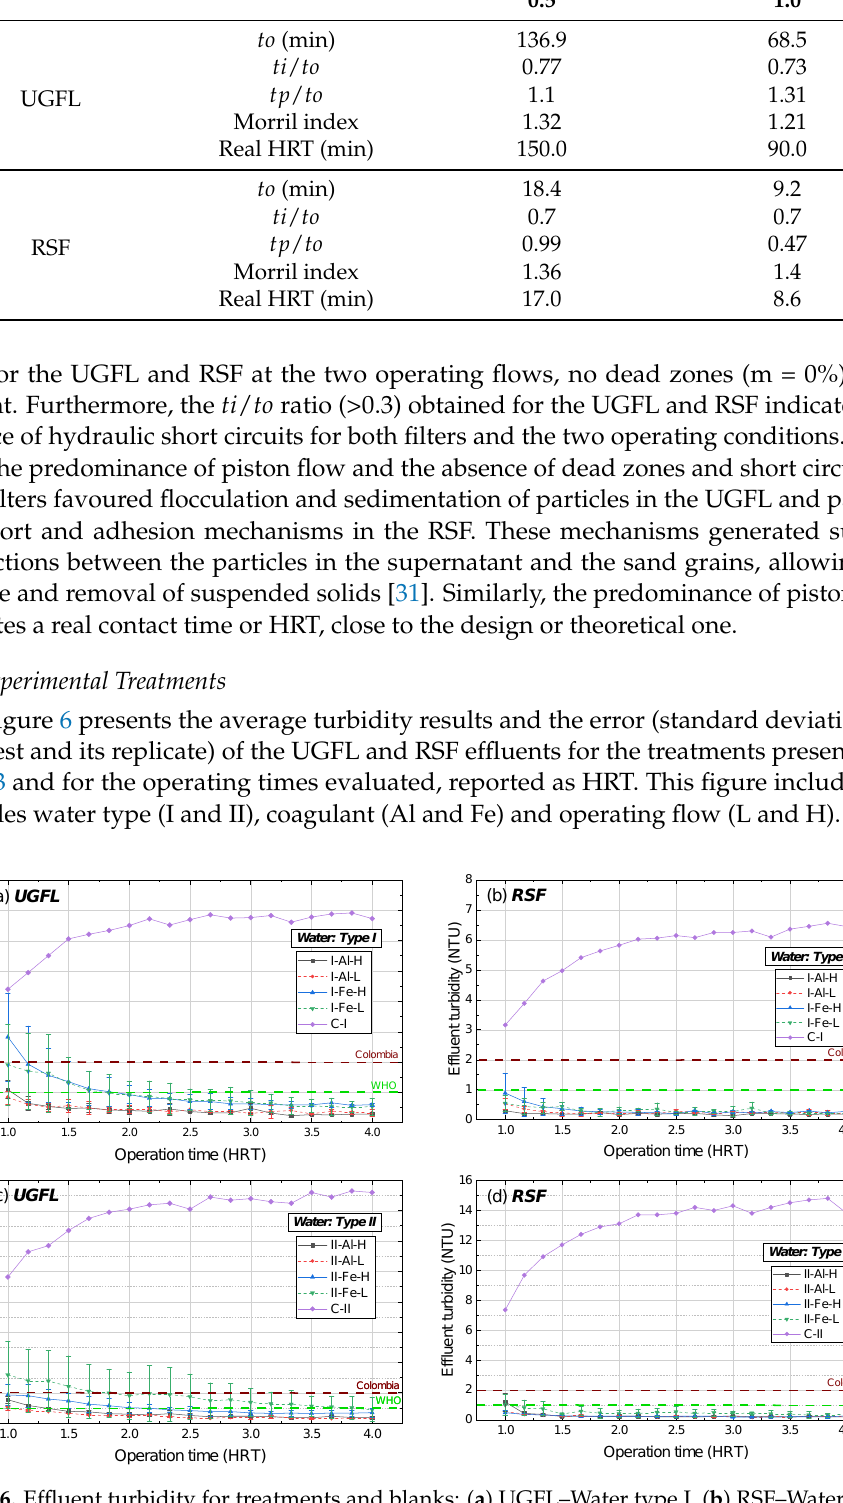
Figure 6. Effluent turbidity for treatments and blanks: ( a ) UGFL–Water type I, ( b ) RSF–Water type I, ( c ) UGFL–Water type II and ( d ) RSF–Water type